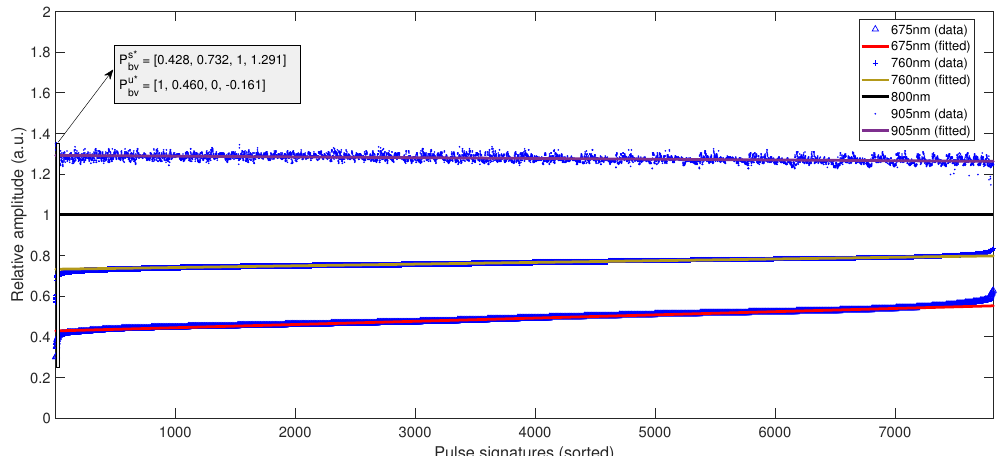
Figure 4. First-order polynomials are fitted on the sorted pulse signatures (by the amplitude of the wavelength with the largest SpO 2 contrast, from high to low SpO 2 ) to estimate the relative SpO 2 sensitivity using iteratively re-weighted least squares with a bisquare weighting